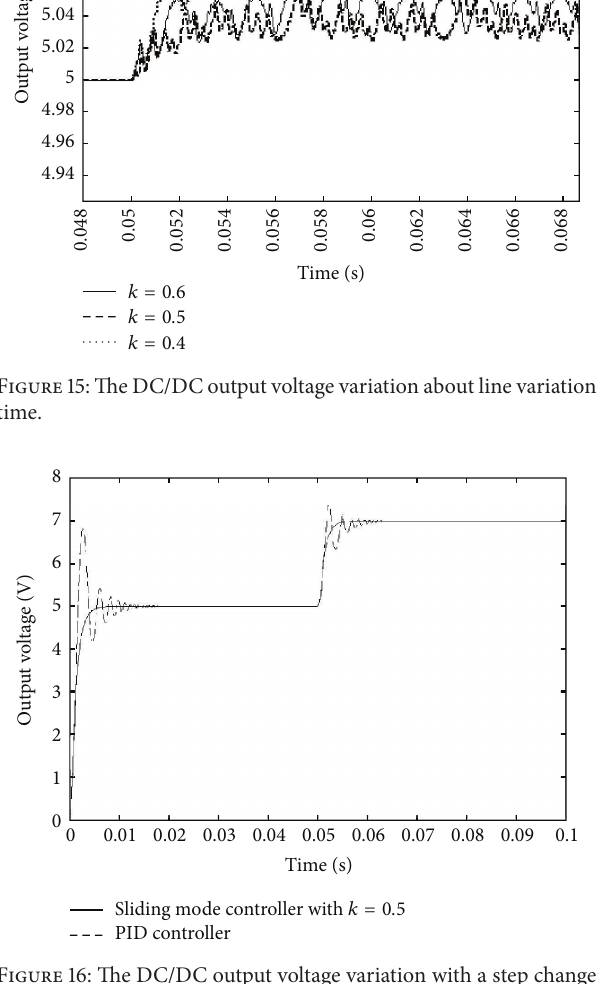
Figure 16: The DC/DC output voltage variation with a step change in reference voltage.